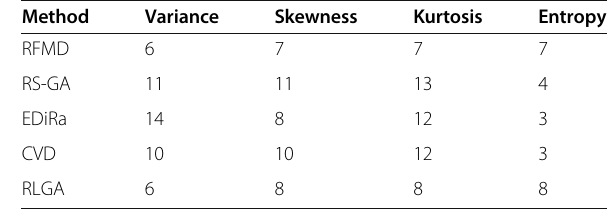
Table 7 Number of discrete intervals in each attribute of the second methylation